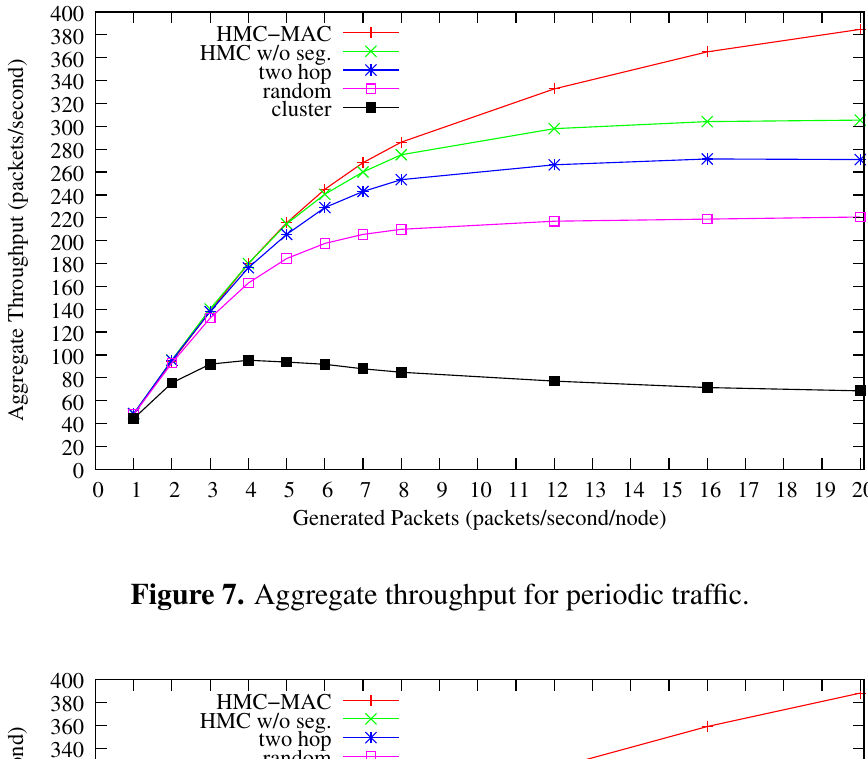
Figure 7. Aggregate throughput for periodic traffic.